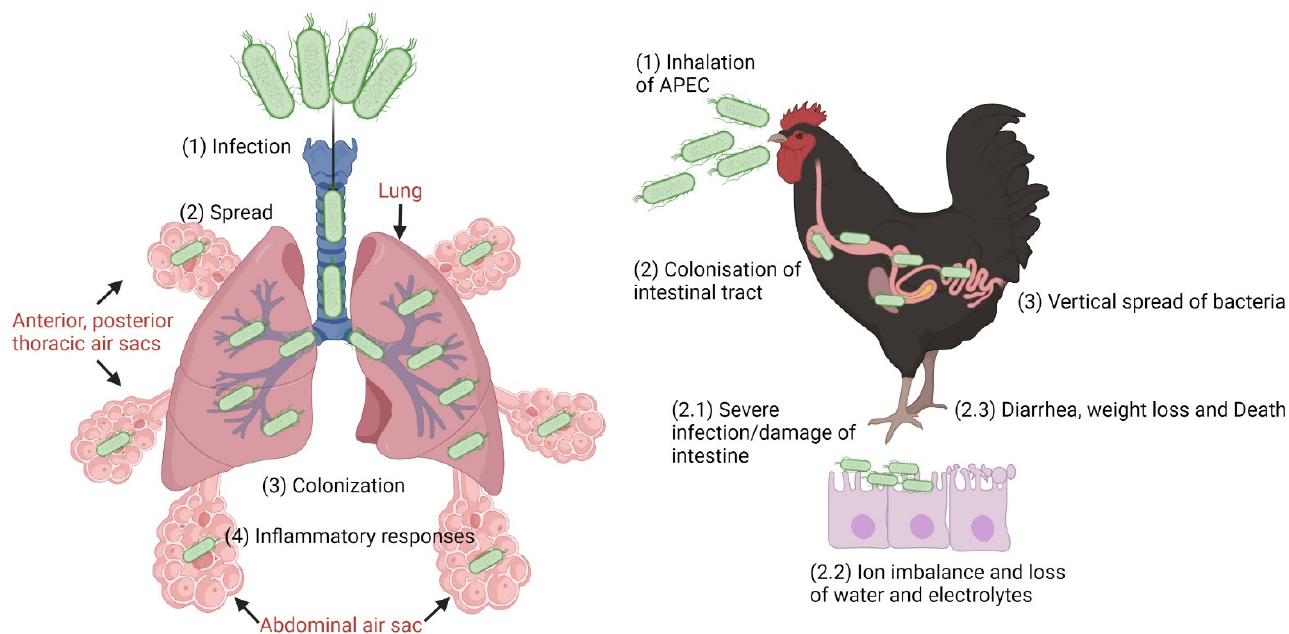
Figure 4. Overview of APEC infection. APEC can reach the trachea by inhalation of contaminated aerosol particles (1). Once inside lung and airsac, the avian immune response is triggered by interactions with pathogen-associated molecular patterns (PAMPS) recognized by receptors such as the Toll-like receptors (TLRs) (2). Inflammatory responses to bacterial infection will elicit macrophages and heterophils to the infected site. Inflammation will lead to tissue damage. APEC can also reach the gastrointestinal tract (2) and sometimes cause diarrhea (2.1,2.2) or invade through intestinal epithelium in presence of environmental stressors (production-related stress, immunosuppression, and concurrent infections) leading to systemic infection (2.3). APEC can be transmitted to other chickens via fecal-oral or aerosol route or vertically spread by infection of eggs (3). The figure was created with BioRender.com (accessed on 22 January2023).